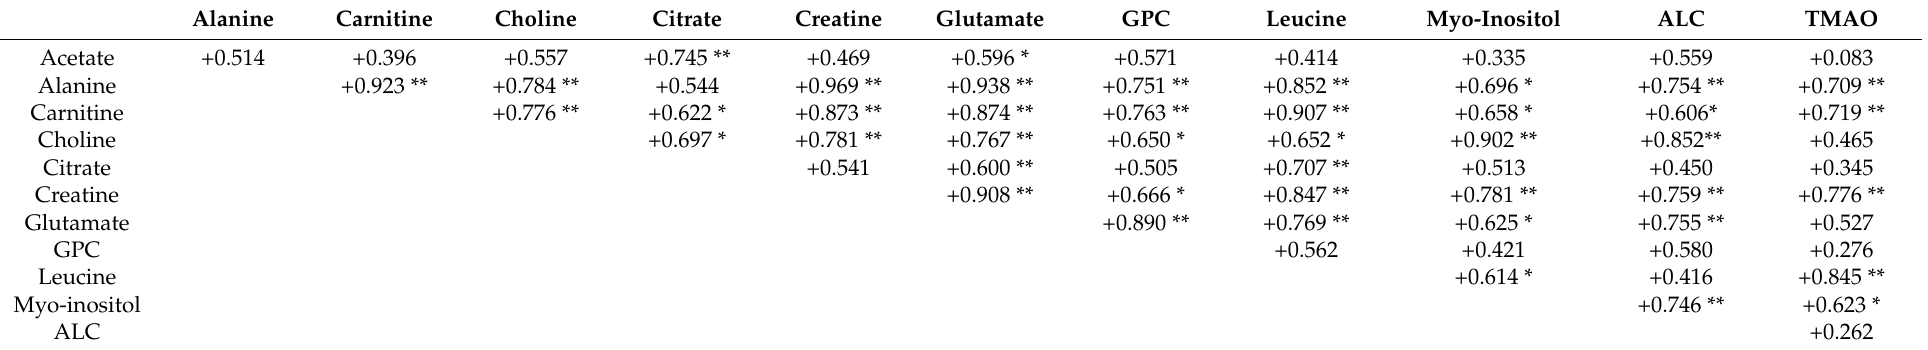
Table 3. Correlation coefficients (R) between seminal plasma metabolites evaluated by 1 H NMR spectroscopy in ten donkey